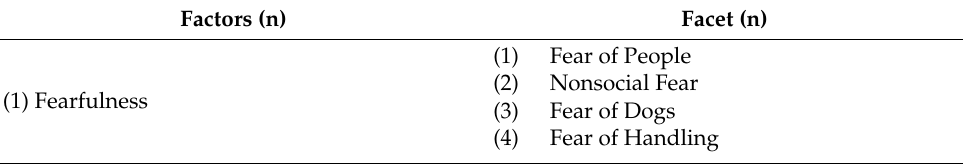
Table 1. Behavioral features considered for the enrolled